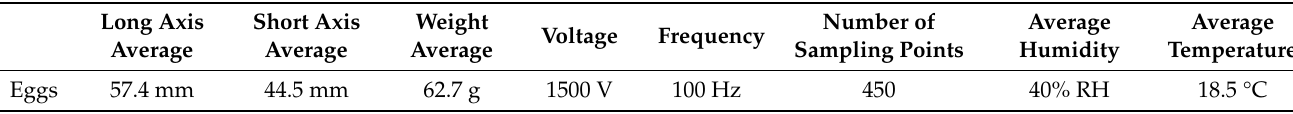
Table 3. Physical and experimental parameters of tested